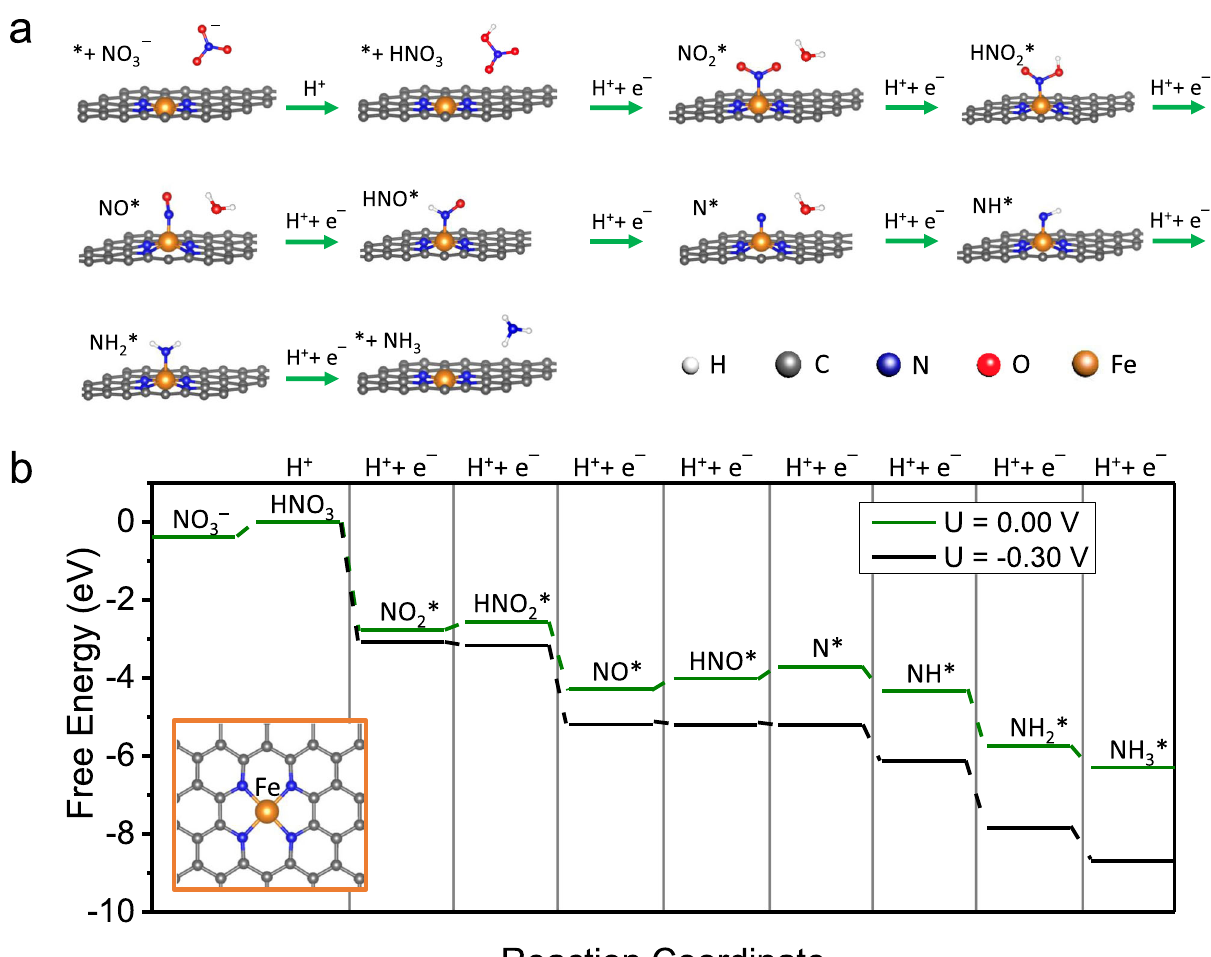
Fig. 4 DFT calculations. a The minimum energy pathway that results in NH 3 as the main product. b Free energy diagram showing the minimum energy pathway at U = 0.0 V vs. RHE (green) and at the calculated limiting potential of − 0.30 V vs. RHE